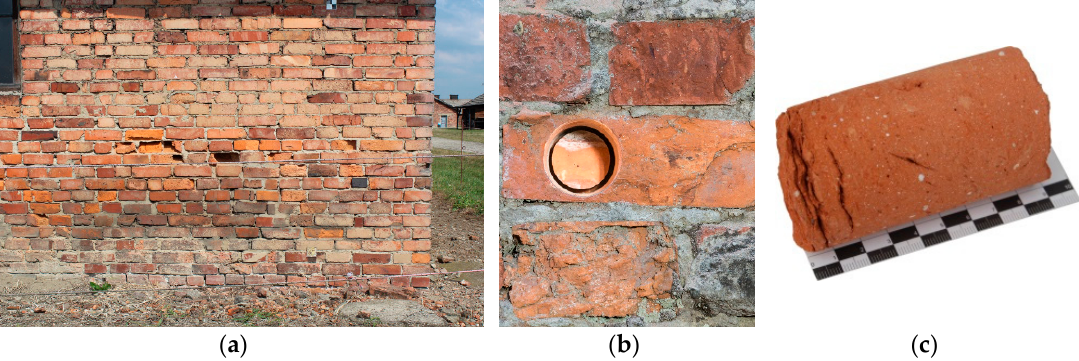
Figure 2. ( a ) Part of a wall of a prisoners’ barracks, ( b ) the place of sampling, ( c ) the collected brick core.